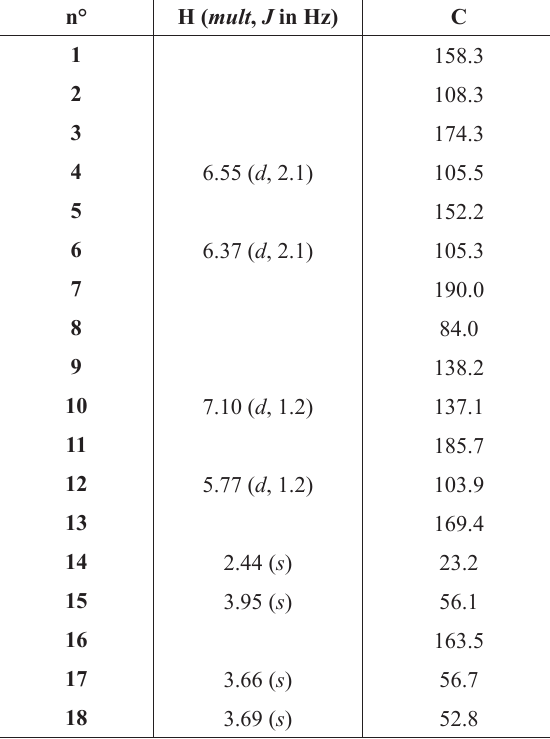
data of the NMR 1 H and 13 C to 5 (300 MHz, CDCl